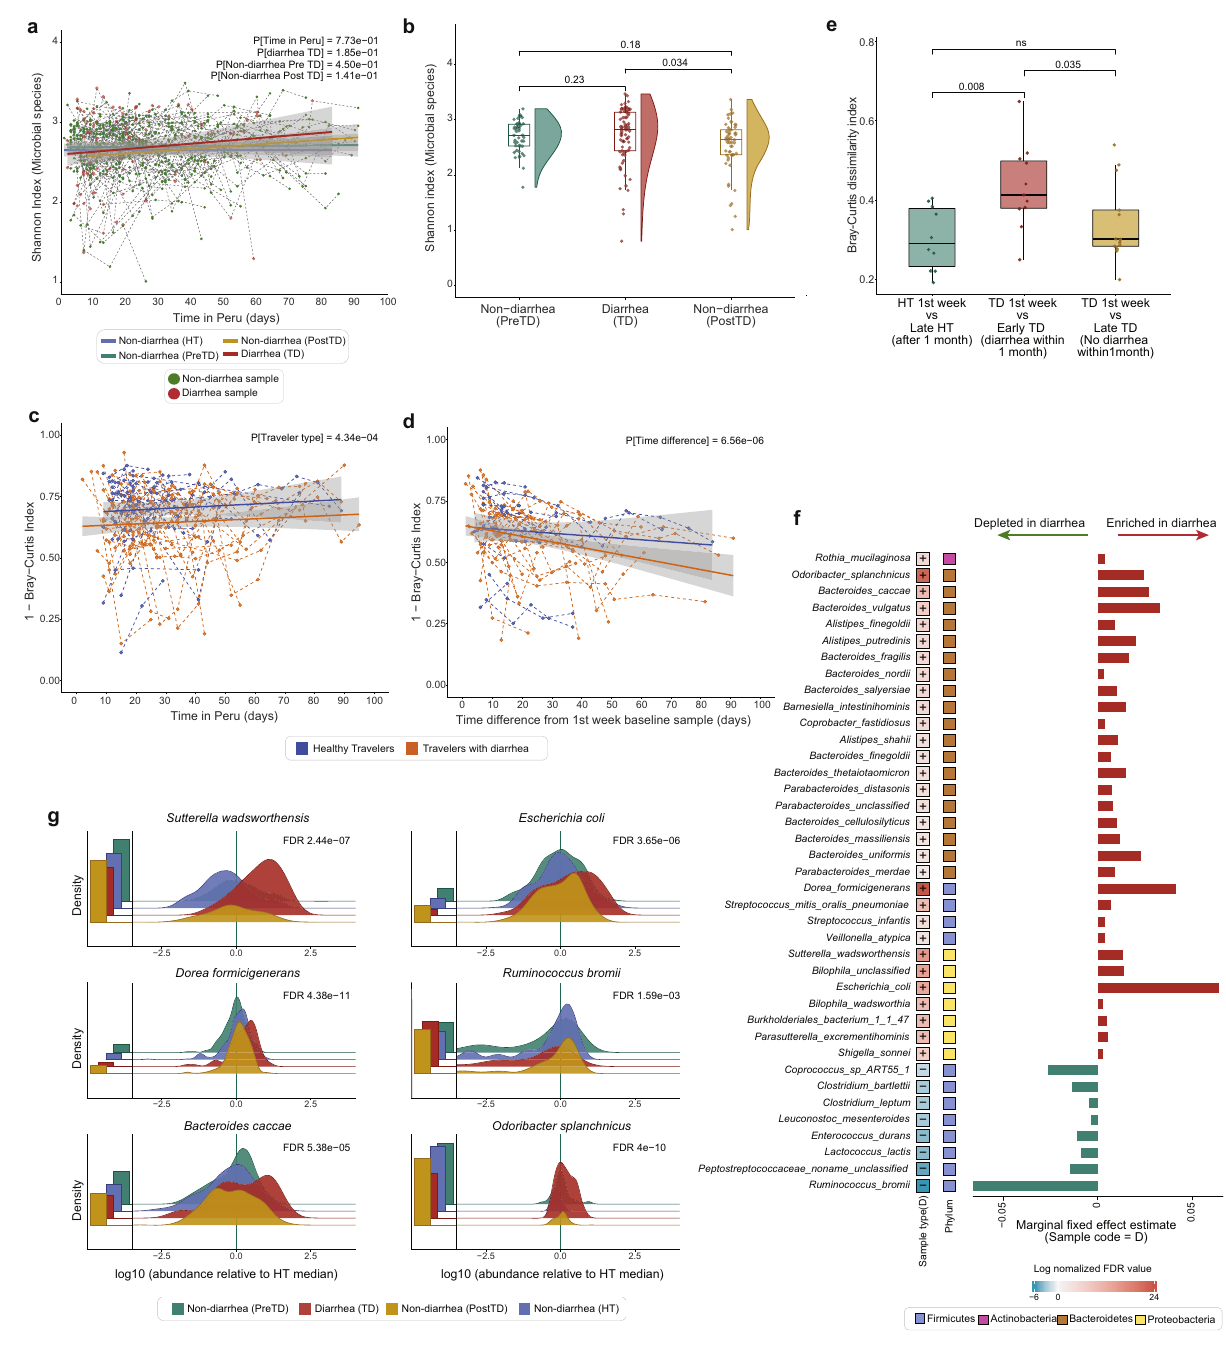
Fig. 2 | Travelers ’ gut microbiome compositions change throughout travel, with diarrhea-causing large-scale disruptions. a Taxonomic diversity (Shannon index) of subjects ’ microbiomes throughout their length of stay, as days post- arrival. Points are individual samples, colored by sample type with dotted lines connecting samples from the same subject. Solid lines show the best fi t line for differentsampletypes:HT(blue),diarrheal(red),non-diarrhealpreTD(green),and postTD samples (yellow) ( n =617, LMM, all P >0.05), and the gray shading repre- sents95%con fi denceinterval(CI). b Boxplotsofthetaxonomicdiversityofsubject- matched diarrheal and non-diarrheal samples collected within 2 weeks ( n =171, LMM, P[DiarrheaTD vs Non-diarrhea PostTD]=3.4e-02). c Bray – Curtis dissim- ilarities between consecutive samples from each subject, plotted throughout their length of stay with dotted lines connecting samples from the same subject. Solid lines show the best fi t for different traveler types ( n =291, LMM, P[Traveler type] <0.001) d Bray – Curtis dissimilarities between each subjects ’ samples and their 1st- week baseline sample ( n =291, LMM, P[Time difference] <0.001) e Boxplots of Bray – Curtis dissimilarities calculated between 1st week baseline sample and a